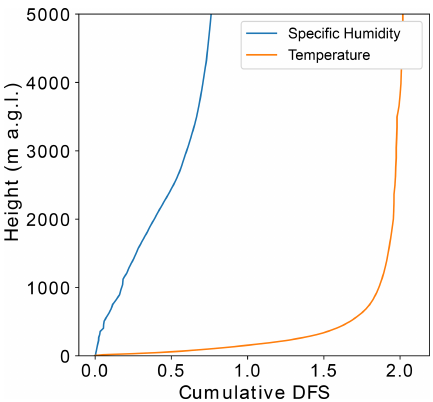
Figure 4. The cumulative degrees of signal for freedom for the syn- thetic temperature (orange line) and humidity (blue line)